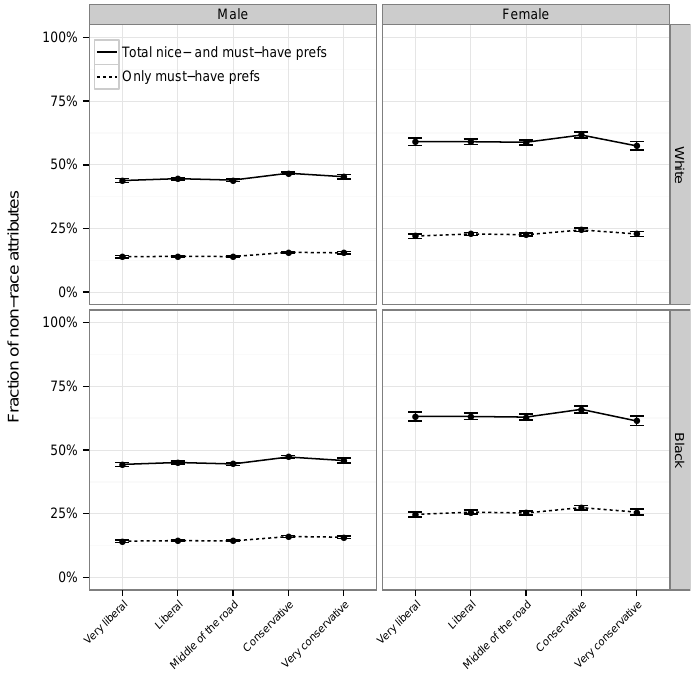
Figure 3: Nonrace selectivity: Estimated fraction of nonrace attributes for which user states preferences, by sex, race, and political ideology. Bars indicate 95 percent confidence intervals. See Table A2 for model